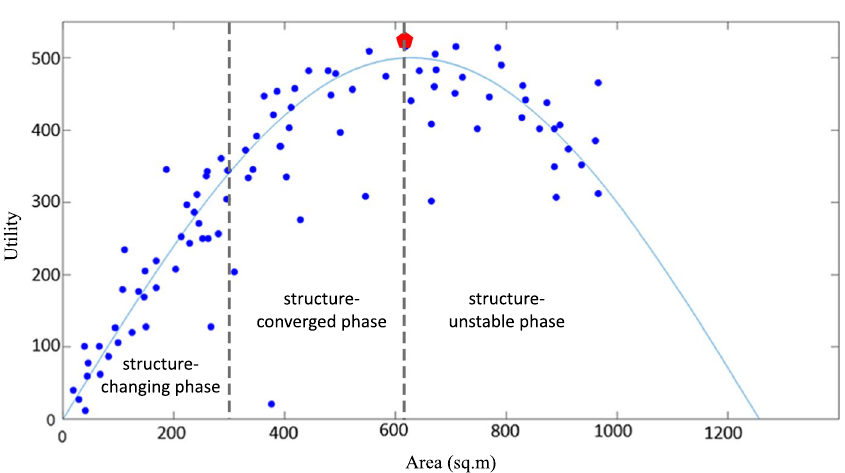
Fig. 8 Most probable coalitional structures under vehicles’ movement and the highest coalition area from utility